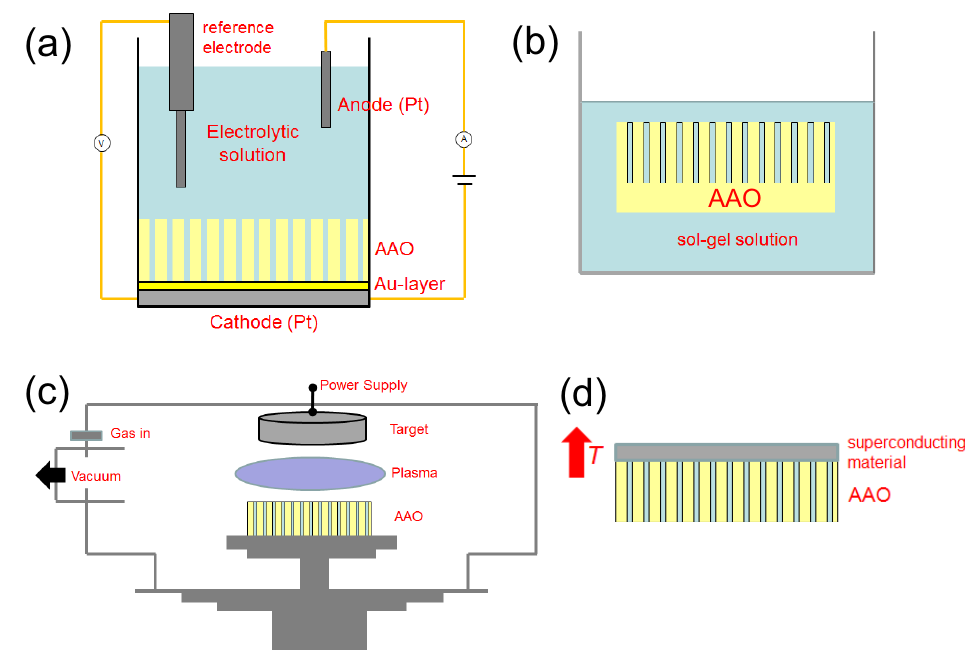
Figure 2. Schemes for filling the porous template material. ( a ) electrodeposition, ( b ) sol-gel solution, ( c ) sputtering, and ( d ) melting. AAO indicates the anodic alumina oxide template as an example. In case ( b ), the alumina oxide at the bottom of the template is useful, whereas it must be removed in ( a